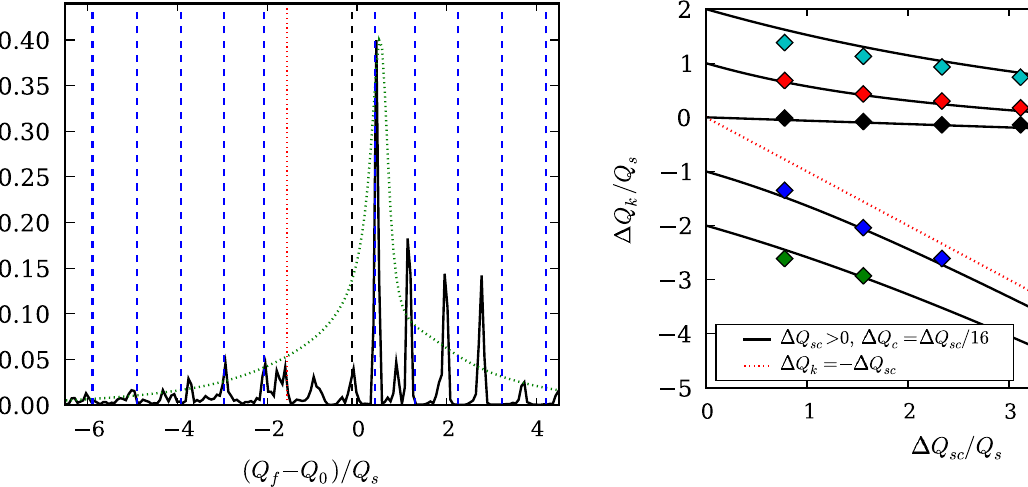
FIG. 8. (Color) Head-tail mode frequencies (cid:1) Q k as a function of the space charge tune shift (cid:1) Q s . The symbols indicate the mode frequencies obtained from the simulation noise spectrum for an elliptic bunch distribution with (cid:1) Q sc ¼ (cid:1) Q max sc .